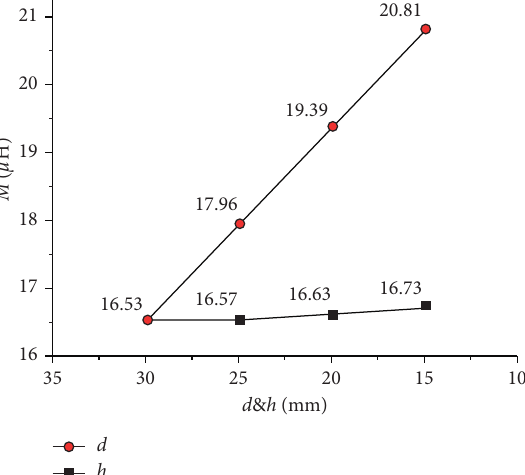
Figure 5: Variation trend of coil mutual inductance.